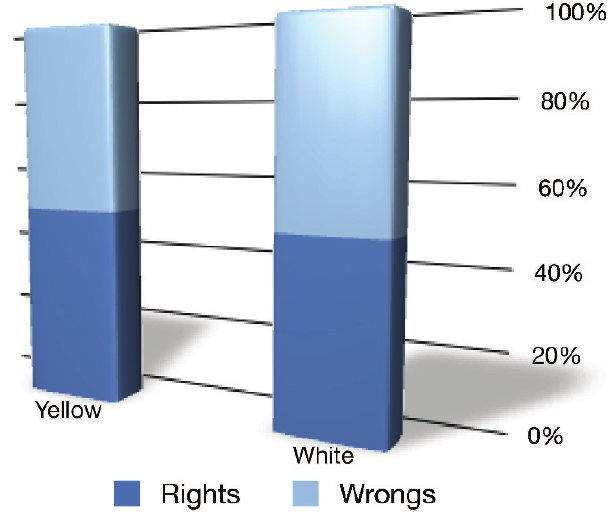
Figure 1 - Percentage of rights and wrongs for both monofila- ments in the